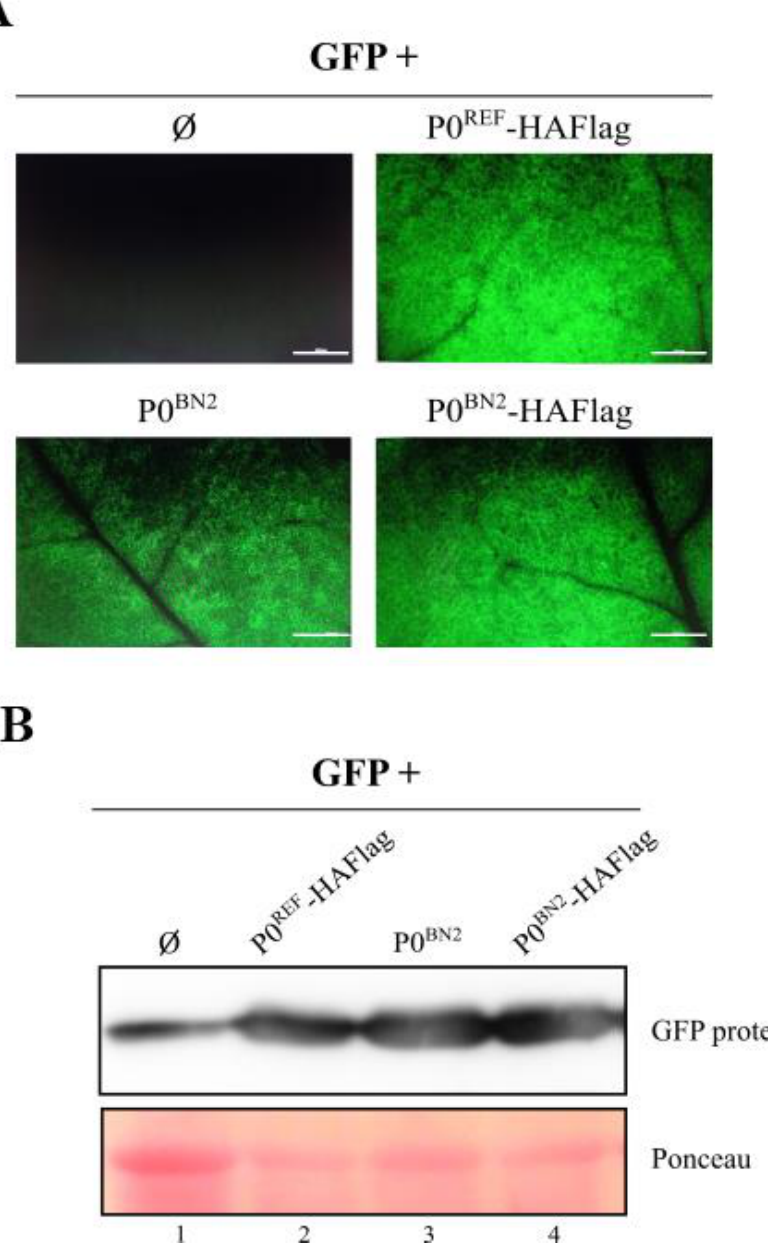
Figure 5. Evaluation of RNA silencing suppressor activity of the natural variant PeVYV-5 P0 BN2 . N. benthamiana leaves were agroinfiltrated with construct for expression of GFP either alone (Ø ) or in combination with constructs directing expression of P0 REF -HAFlag, P0 BN2 or P0 BN2 -HAFlag. ( A ) GFP fluorescence at 10 dpif in infiltrated leaf patches. The inset scale bar corresponds to 5 mm in all panels. ( B ) Western blot for detection of GFP. Ponceau S staining is shown below Western results as loading control.